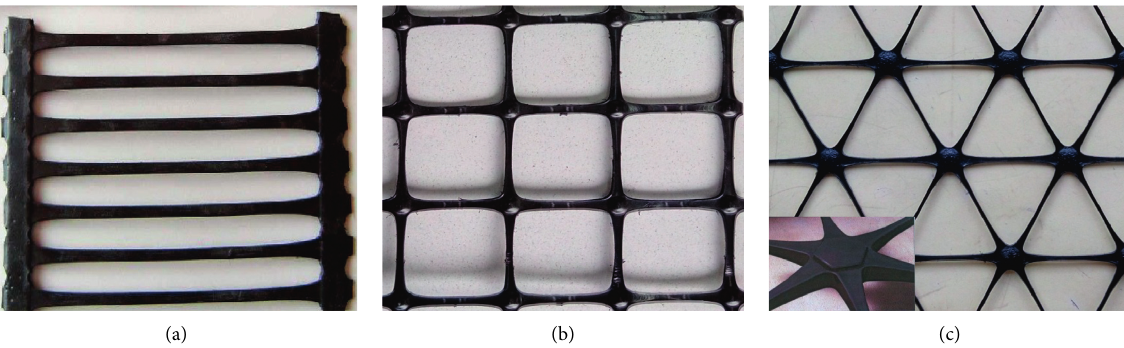
Figure 1: Three kinds of geogrids. (a) Uniaxial geogrid. (b) Biaxial geogrid. (c) Triaxial